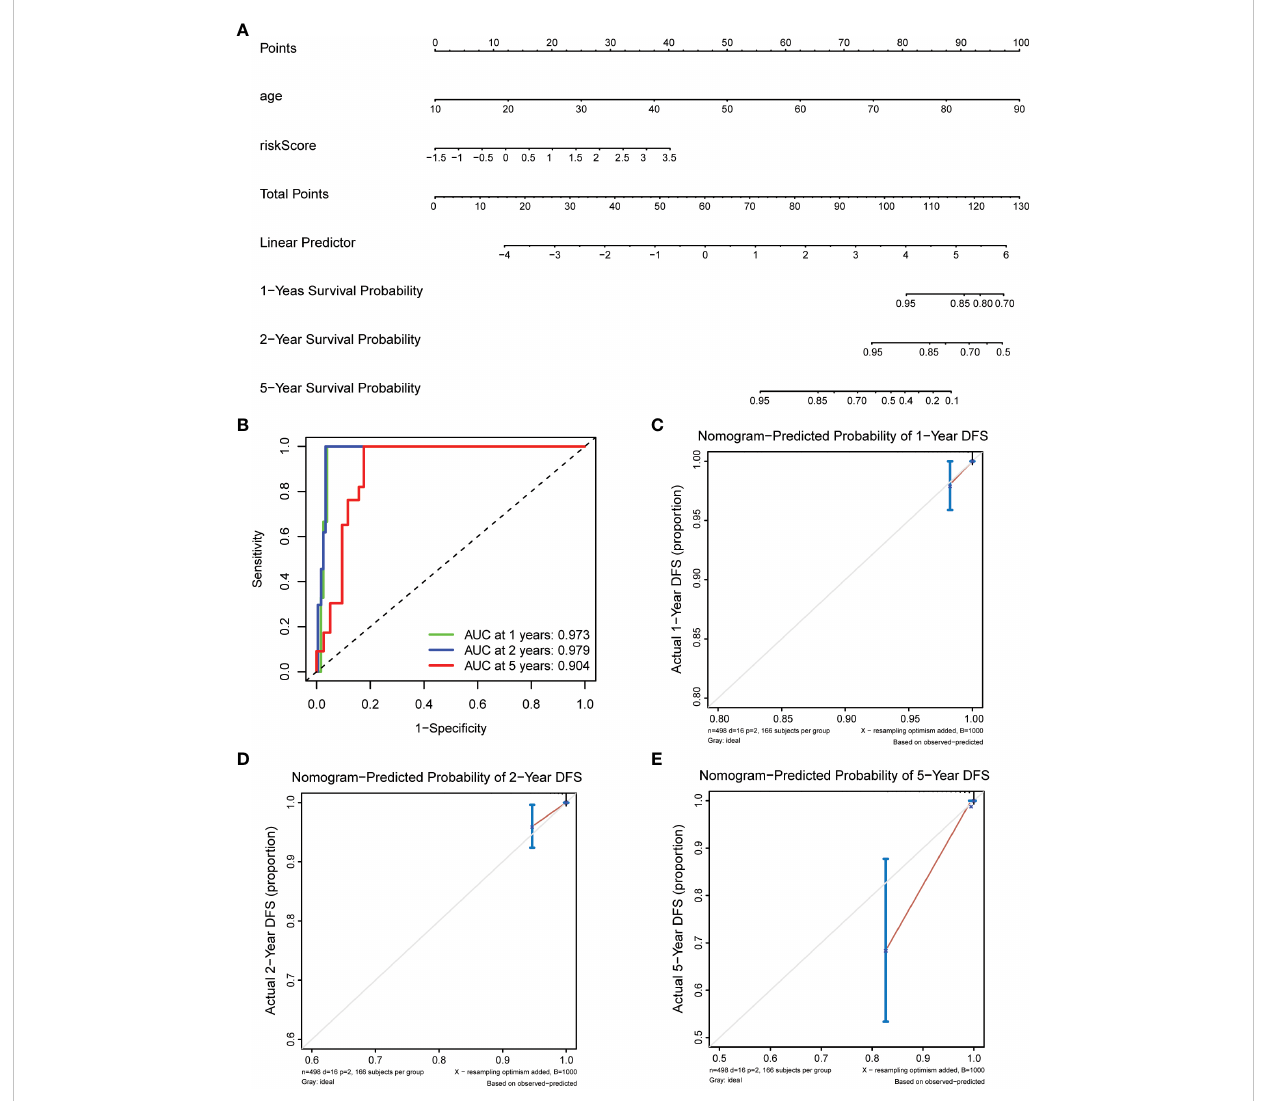
FIGURE 1 Construction of nomogram models for thyroid cancer. (A) A nomogram combining the risk score and age. (B) AUC of time-dependent ROC curves evaluated the prognostic capacity of the nomogram. (C – E) Calibration curves comparing the nomogram-predicted (C) 1-, (D) 2-, and (E) 5-year survival and actual